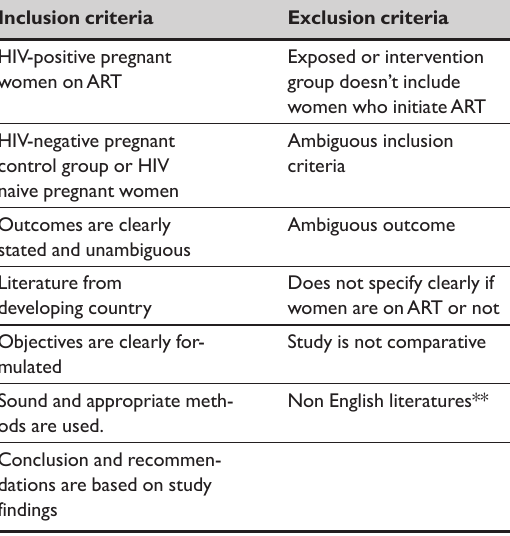
Table 2. Inclusion and Exclusion